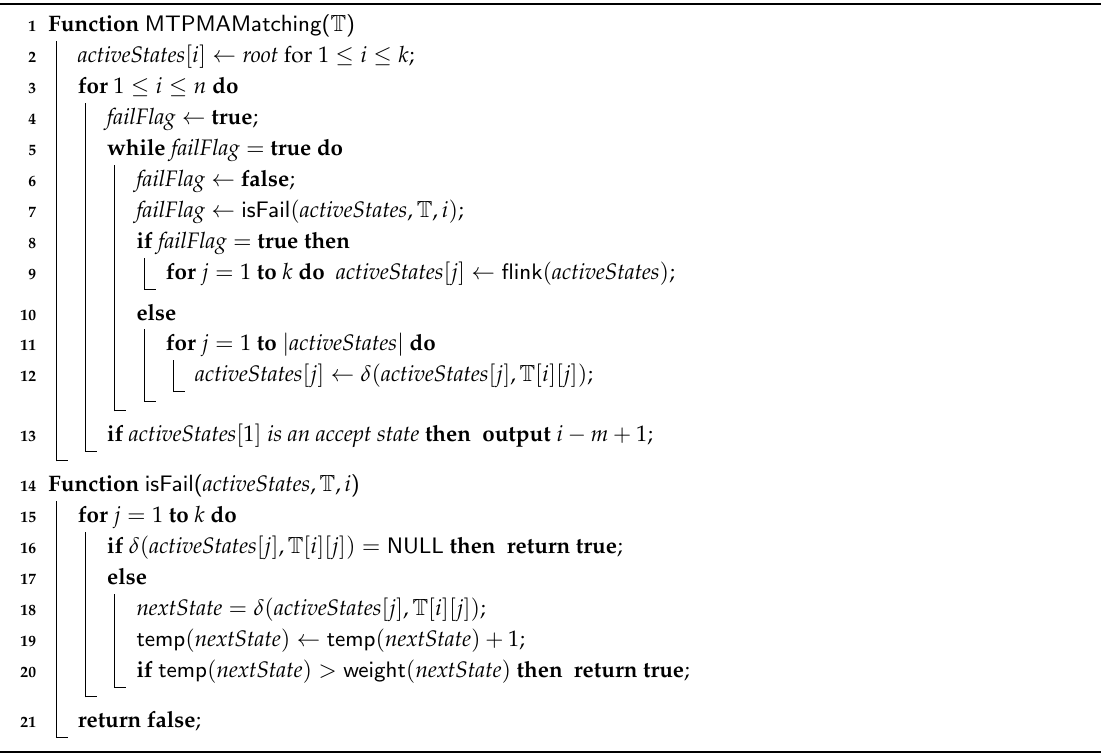
Algorithm 9: Multi-track permuted matching automaton matching